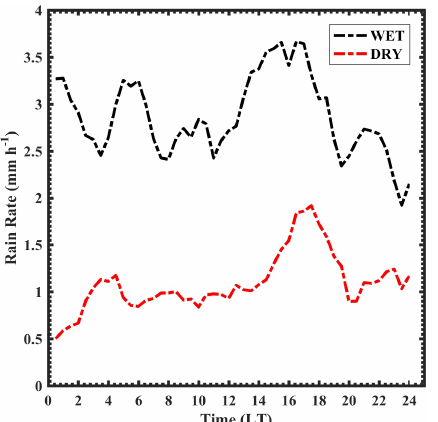
Figure 11. Diurnal variation of the mean rain rate (mmh − 1 ) for wet and dry spells.